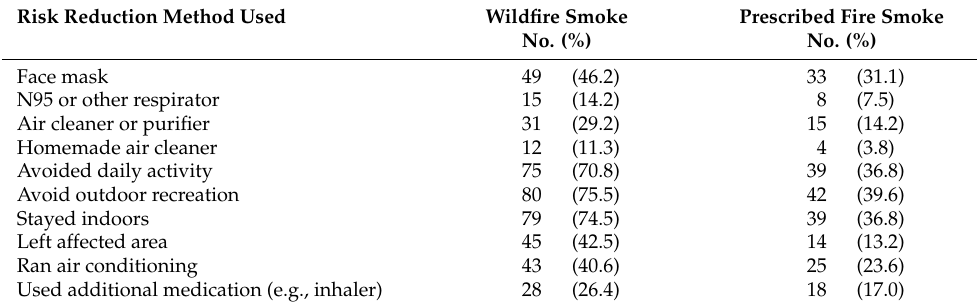
Table 2. Actions taken to reduce risk reported by respondents in a survey of a medically vulner- able adult population regarding wildfire and prescribed fire smoke (N = 106), Mariposa County, California, 2021 a